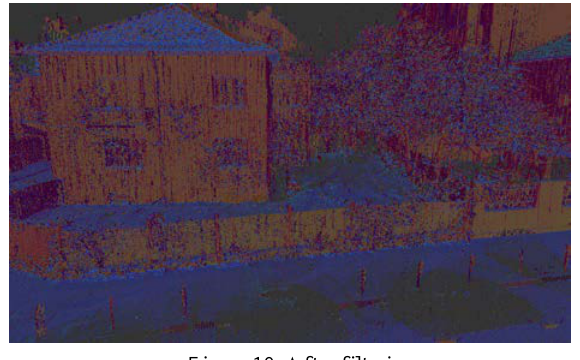
Figure 19: After filtering